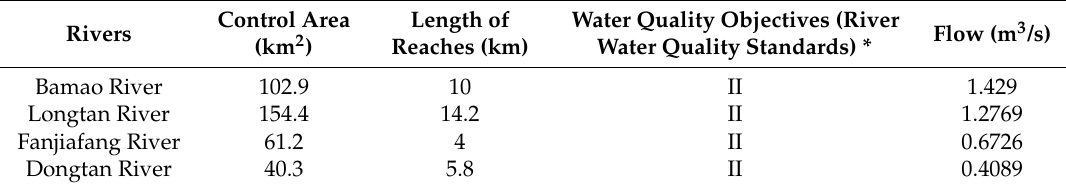
Figure 1. The location of the Huangshi Reservoir and the sample points of water quality. Table 1. The features of the tributaries.